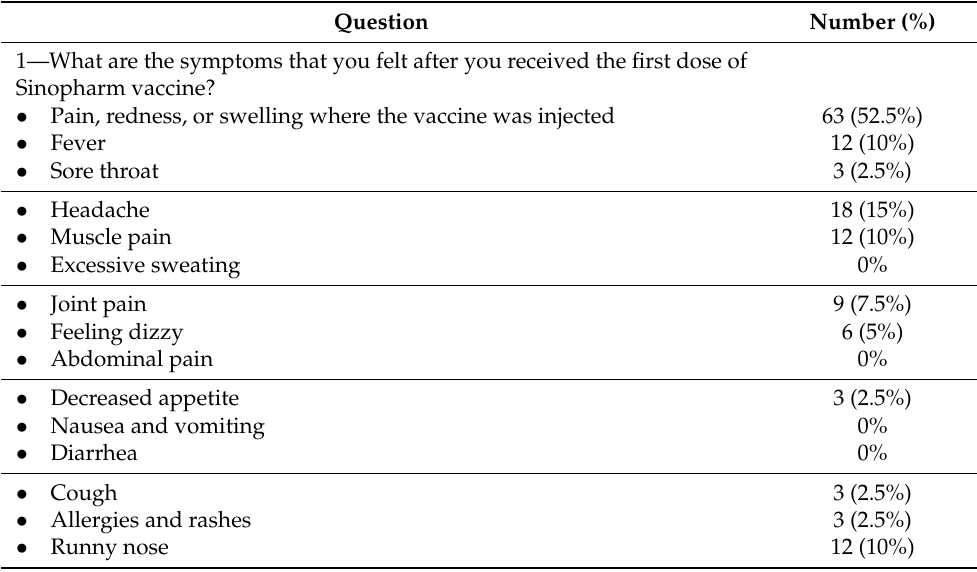
Table 2. Symptoms and practices following the first dose of the Sinopharm